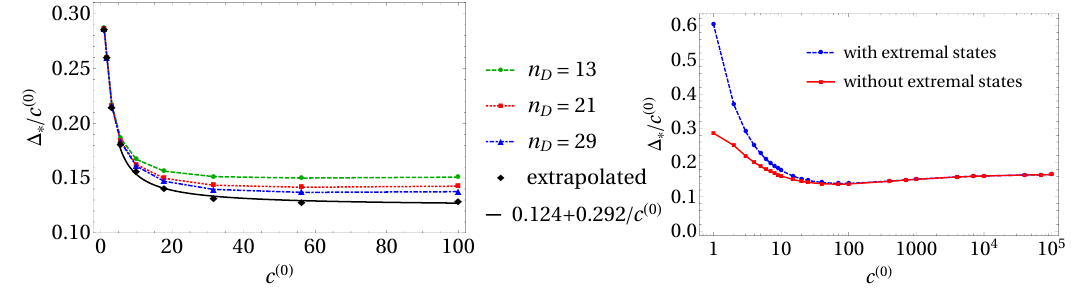
Figure 11 . Bound on SU(2) k = 1 gaps in (cid:1) universal for all representations for 1 (cid:20) c (cid:20) 100. Left: bounds obtained with di(cid:11)erent values of n D when extremal states are not allowed. Dashed lines from blue to red are computed data of 3 (cid:20) n D (cid:20) 29. The solid black line is extrapolated from data of 11 (cid:20) n D (cid:20) 29 using a function linear in 1 =n D . Right: bounds extrapolated to n D = 1 for the analysis without extremal states compared to the result when extremal states are allowed. The di(cid:11)erence is negligible at large c but signi(cid:12)cant at small c .